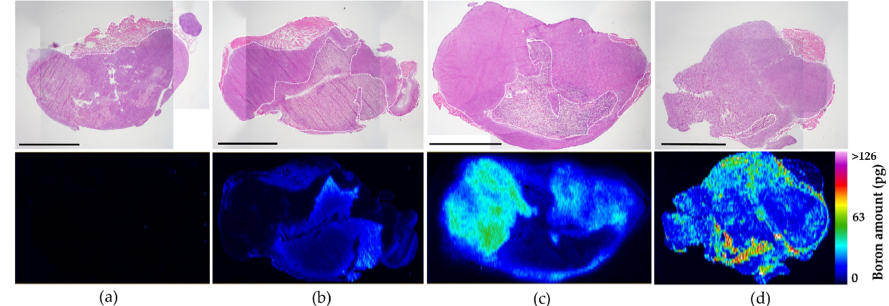
Figure 7. In vivo fluorescence imaging of 10 B distribution of 10 B-MMT1242 in tumor tissues. An in vivo 10 B distribution study showing slightly heterogeneous but broad range of 10 B distribution in tumor tissues after 10 B-MMT1242 administration ( d ) compared to control ( a ), 10 B-BSH ( b ), and 10 B-BPA ( c ). Each black scale bar stands for 5mm. Each white dotted line in the figures represents interstitial spaces in the tumor tissues.